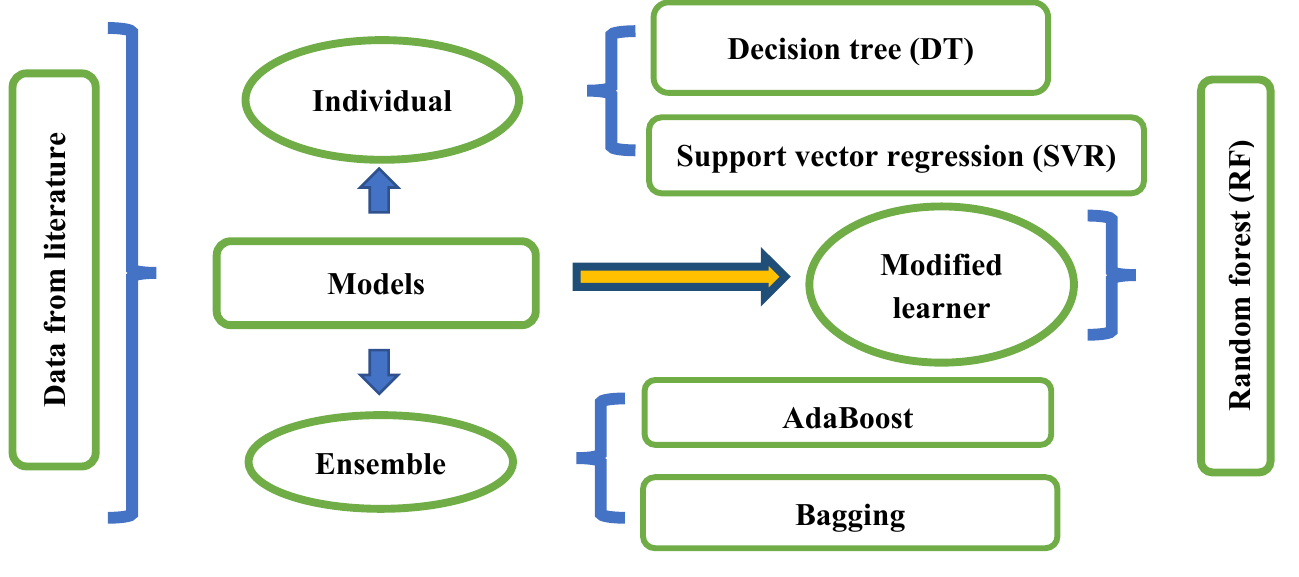
Figure 2. Flow diagram of models used in this research.